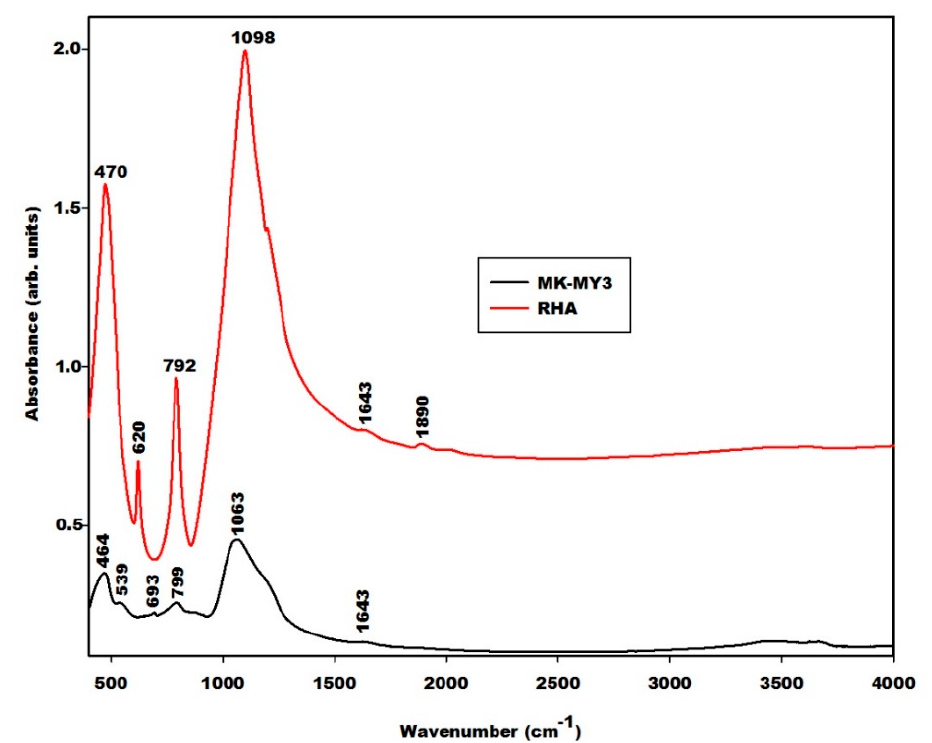
Figure 4. Infrared spectra of rice husk ash (RHA) and metakaolin